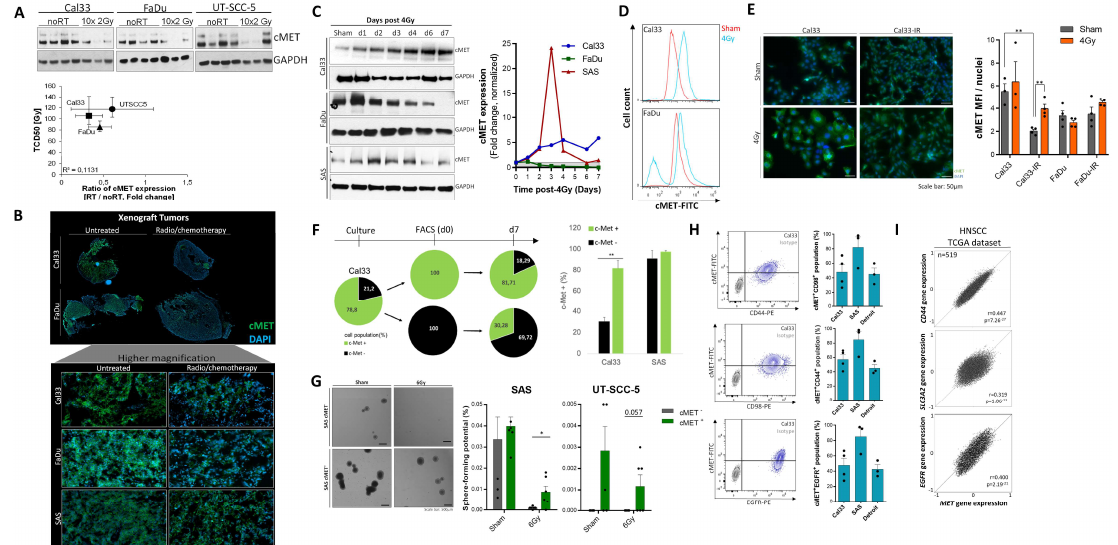
Figure 3. Cellular plasticity and self-renewal properties of the c-MET-population in HNSCC. ( A ) c-MET protein ex- pression within Cal33, FaDu, and UT-SCC-5 xenograft tumors that were treated with 10 fractions of 2 Gy within two weeks. Correlation of tumor control doses 50% with ratio of c-MET protein in irradiated cohort to sham control. ( B ) Immunofluorescence-based evaluation of c-MET expression in s.c. xenograft tumors originating from Cal33, FaDu, and SAS that were treated with cisplatin-based radio/chemotherapy in 10 fractions after randomization when tumors reached a diameter of 7 mm ( n = 8–15). Tumors were fixed 24 h after last fraction and the formalin-fixed paraffin-embedded (FFPE) tissue was cut into 4 µ m sections and stained with anti-c-MET antibody. ( C ) Single dose irradiation with 4 Gy modulates the c-MET protein expression in Cal33, FaDu, and SAS differently in a time-dependent manner within one week. Semi-quantitative analysis of this Western blot using ImageJ demonstrated a dynamic up-regulation of c-MET in Cal33 and SAS as well as a down-regulation in FaDu cells ( n = 2). ( D ) Flow cytometry-based analysis validated the irradiation-induced upregulation of c-MET on cell membrane 2 days after irradiation with 4 Gy. The depicted overlay histogram compares sham control (red) and post-irradiated cells (blue) for Cal33 and FaDu labeled with c-MET-Alexa488 antibody. ( E ) Immunofluorescence analysis illustrates an increased c-MET expression 5 days upon 4 Gy irradiation and a reduced c-MET signal in IR subclones. c-MET membrane expression and intracellular localization was visualized